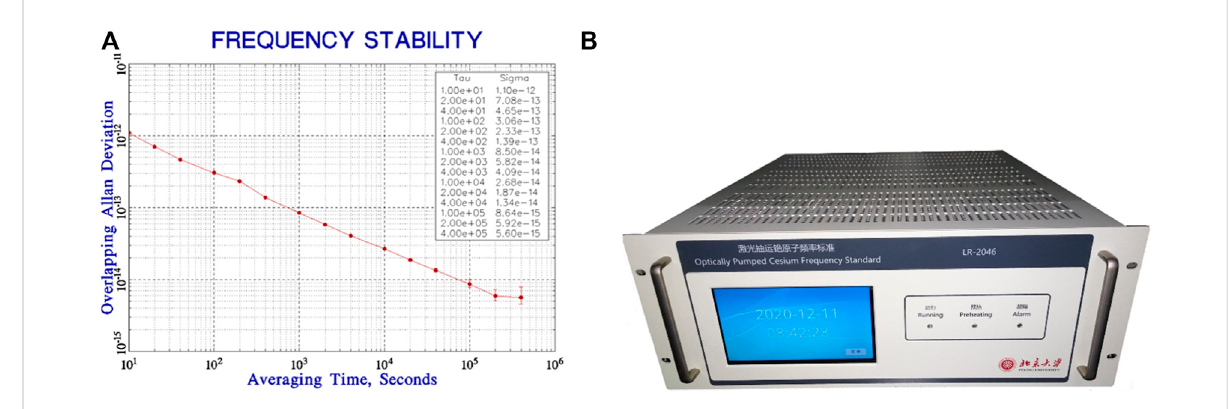
FIGURE 3 (A) Frequency stability curve for the optically pumped cesium clock. (B) Portable optical pumped cesium